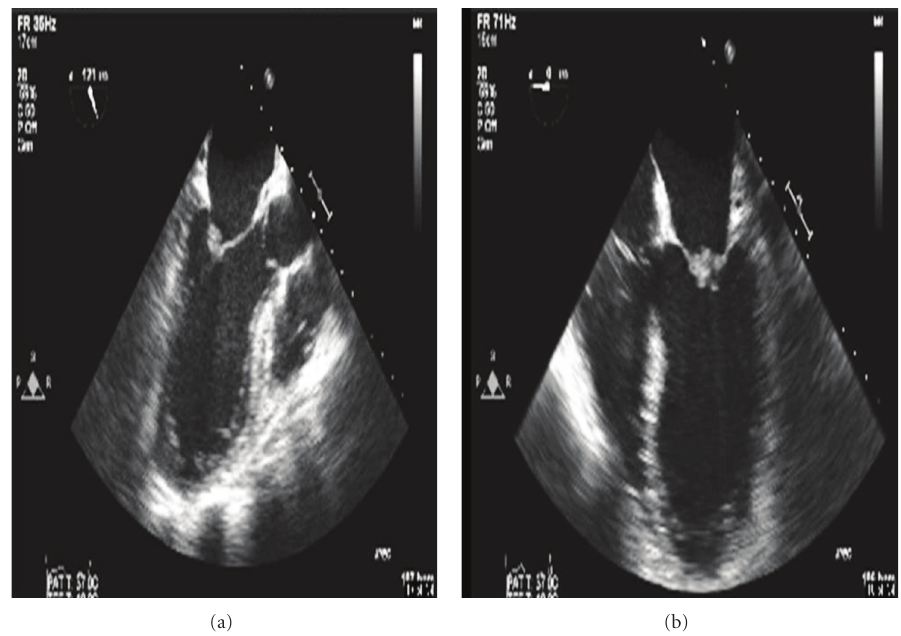
Figure 2: A transesophageal echocardiogram showing vegetation on the mitral